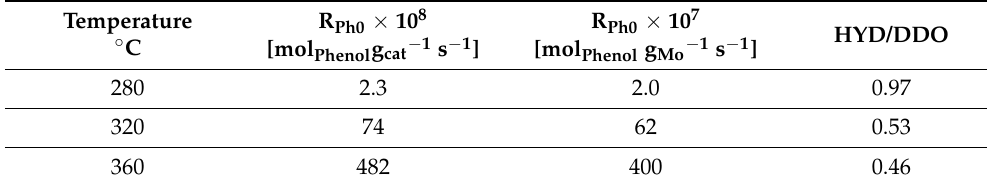
Table 2 . Statistical model. Responses: Initial reaction rate of phenol R Ph0 and selectivity and Factors: Temperature (T, °C), Pressure (P, MPa) and Mo loading (C, wt.%) and their respective correlation coefficients.